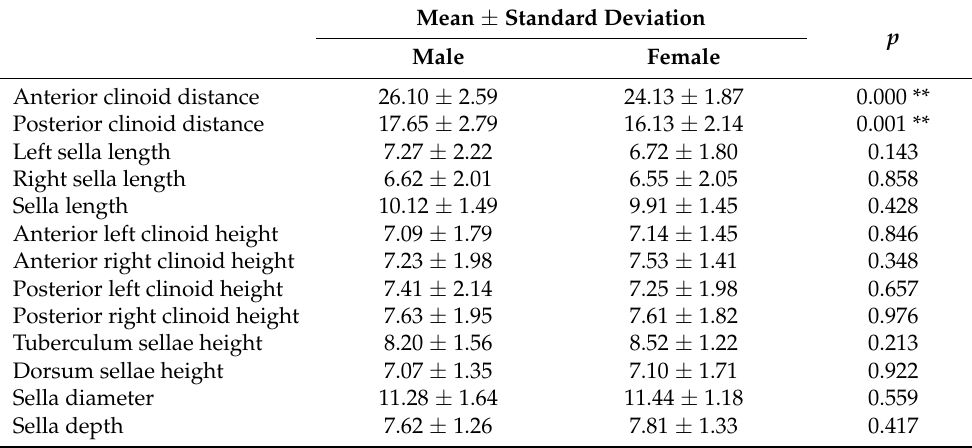
Table 6. Differences in sella turcica dimensions between genders.